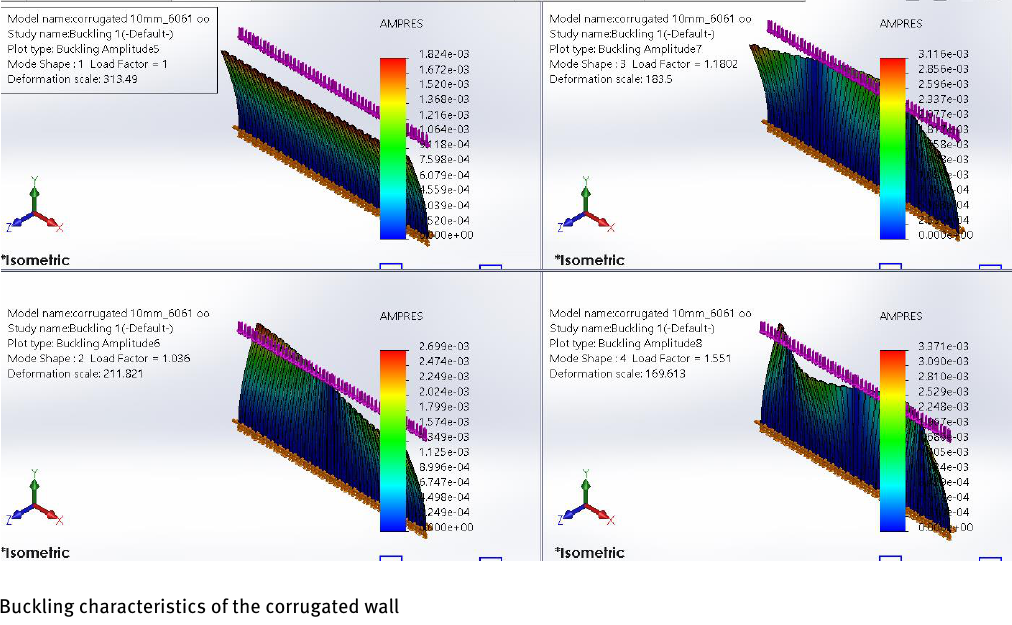
Figure 36: Buckling characteristics of the corrugated wall